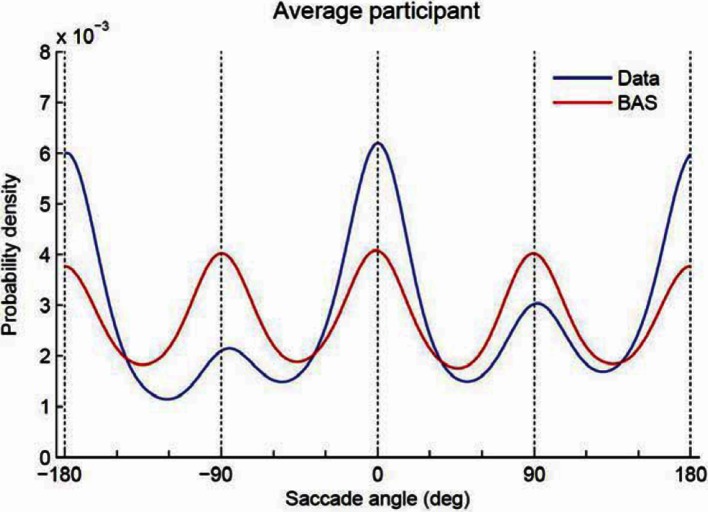
Probability density of saccade angles.